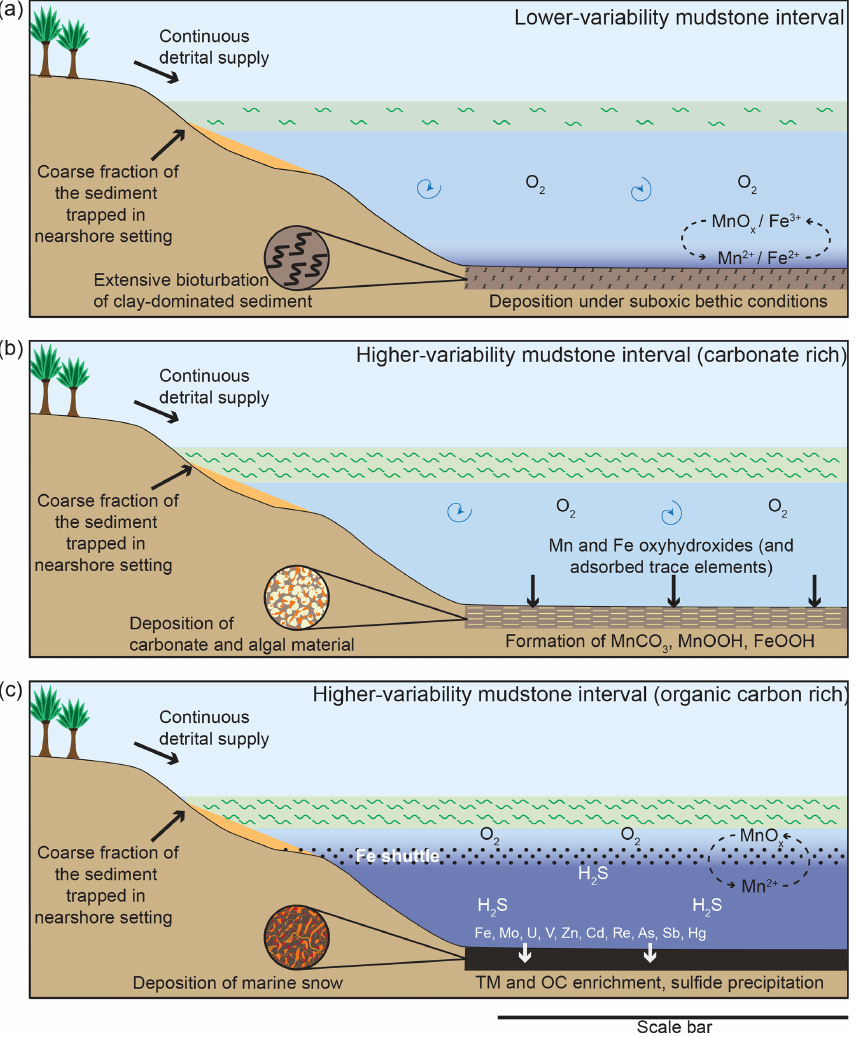
Figure 11. Schematic diagram illustrating depositional conditions during the different intervals of sedimentation. (a) Lower-variability mudstone interval, (b) periods of carbonate-rich sedimentation in the higher-variability mudstone intervals, and (c) periods of organic- carbon-rich sedimentation during the higher-variability mudstone intervals. The scale bar represents bathymetric lows, generally considered to be tens to hundreds of kilometres